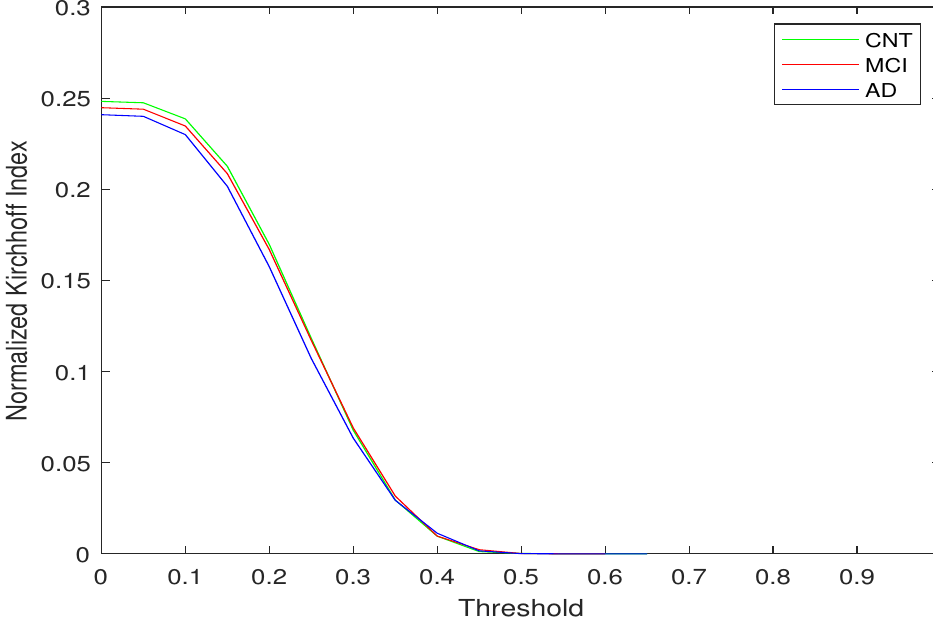
Figure 6. Mean values of the Normalized Kirchhoff Index ( K f ( G ) norm ) computed by thresholding the connection matrices of CNT, MCI, and